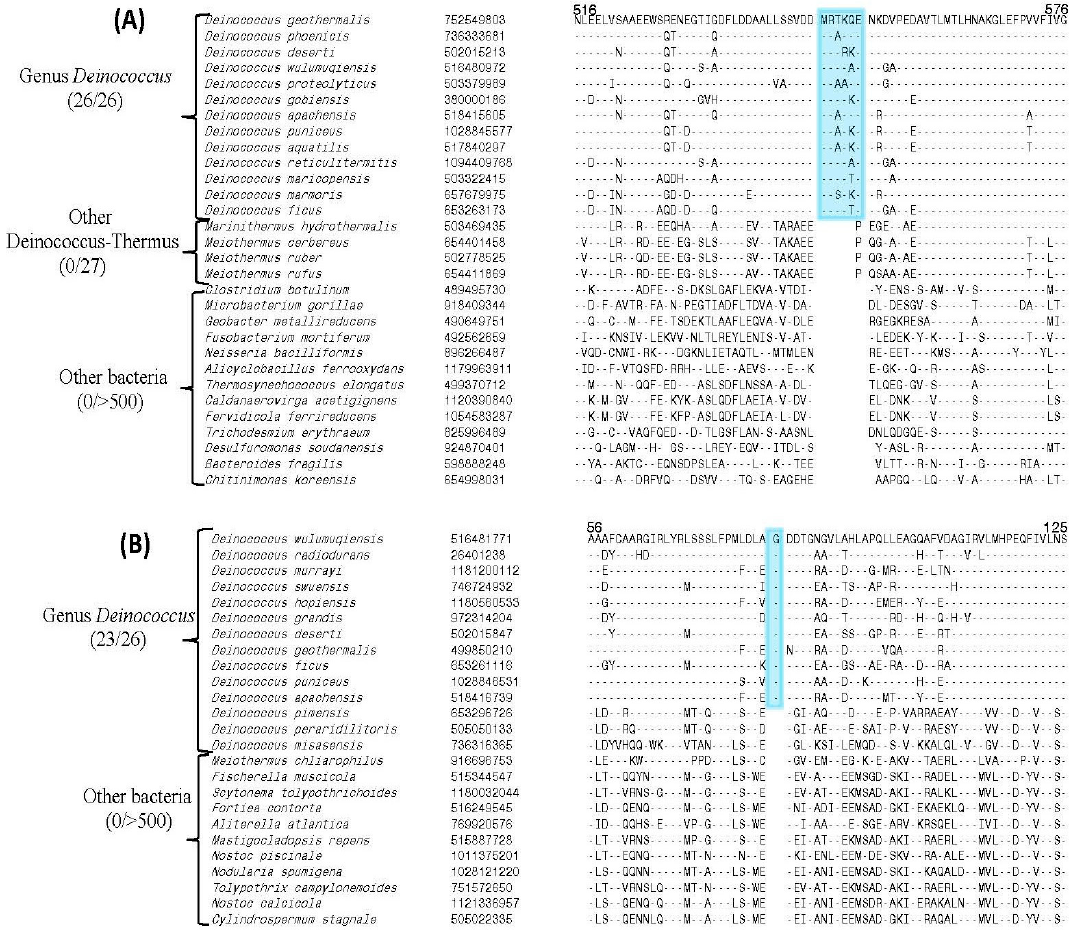
Figure 2. Partial sequence alignment showing conserved indels in ( A ) DNA helicase (UvrD) protein and ( B ) UV damage endonuclease (UvsE) protein which are specific for Deinococcus .